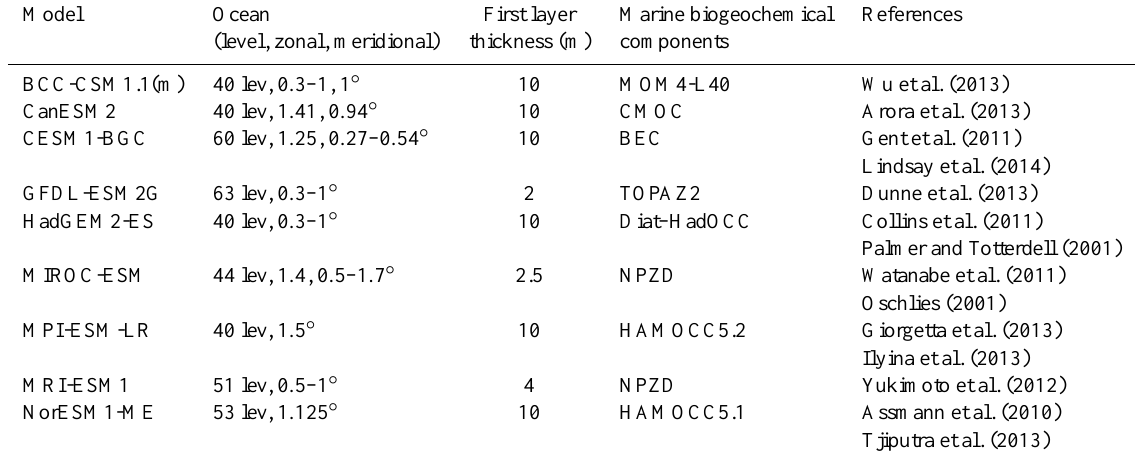
Table 1. Description of the models analyzed in this study, indicating ocean model resolutions (levels in the vertical and horizontal resolution in degrees), the thickness of the surface layer, and the marine biogeochemical components included in the ESM.